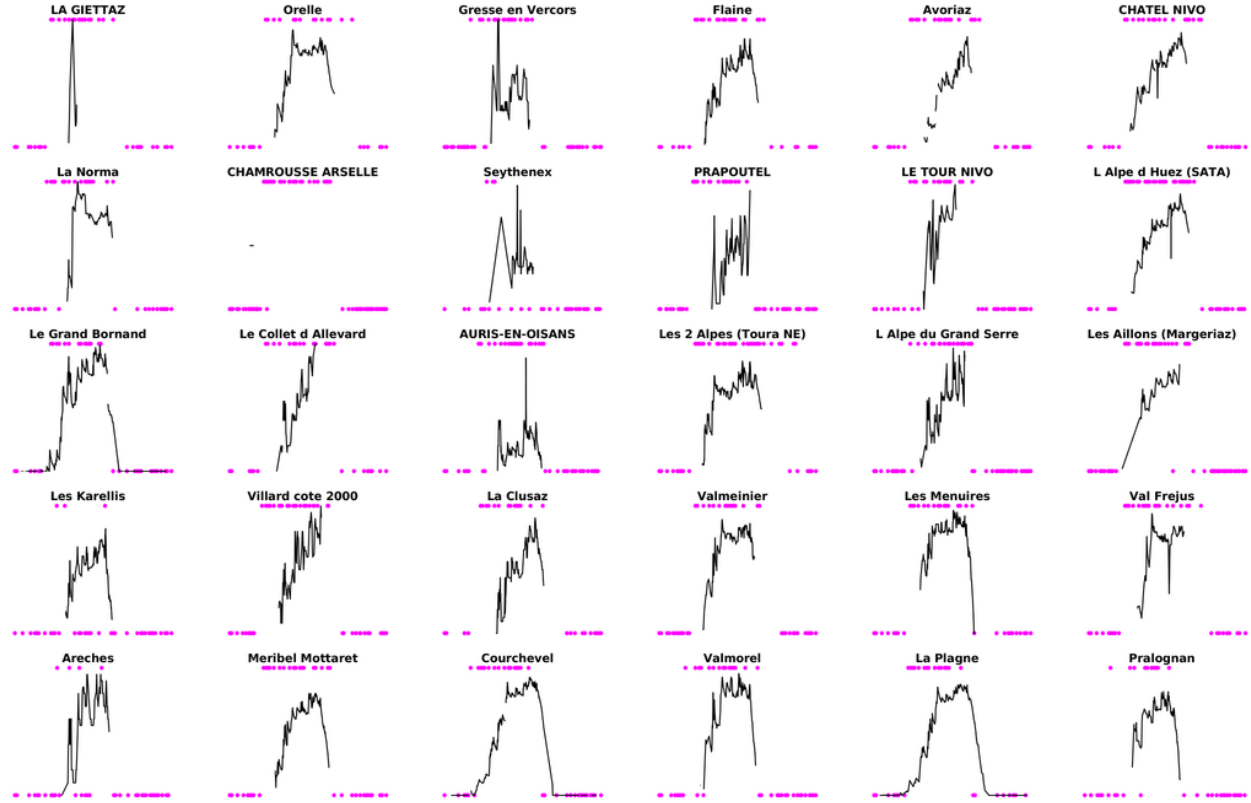
Figure B2. Magenta dots: snow presence (a) or absence (b) in the Theia snow collection. Black line: snow depth time